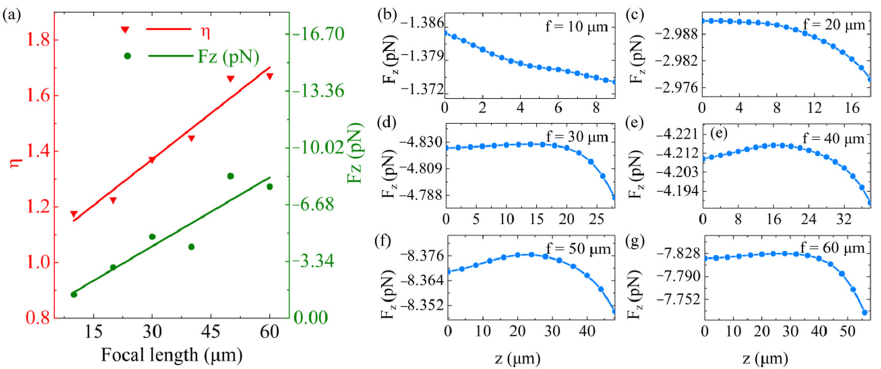
Figure 7. The OPF on the metalenses with different focal lengths f . ( a ) The OPF and η as a function of f . The OPF profiles on the z -direction ( x = y = 0) at the f of ( b ) 10 μ m, ( c ) 20 μ m, ( d ) 30 μ m, ( e ) 40 μ m, ( f ) 50 μ m and ( g ) 60 μ m, respectively. f . The OPF profiles on the z -direction ( x = y = 0) at the f of ( b ) 10 µ m, ( c ) 20 µ m, ( d ) 30 µ m, ( e ) 40 µ m, ( f ) 50 µ m and ( g ) 60 µ m,